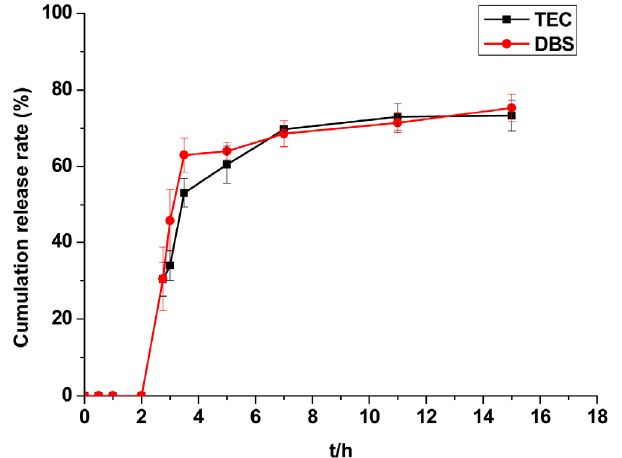
Figure 4. The effect of various plasticisers on the release of CAP from CCMS enteric coated tablets. Each point represents the mean ± SD. Abbreviations: TEC, triethyl citrate; DBS, dibutyl